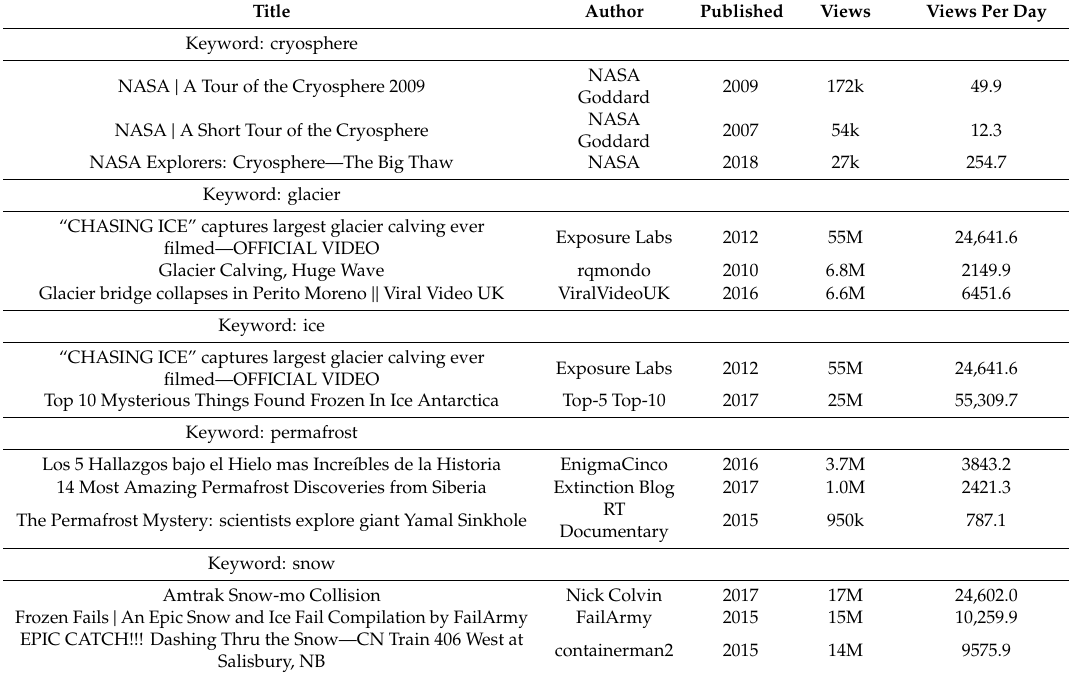
Table 2. The top-viewed videos with cryospheric content. Three top-viewed videos (total views; in February 2019) are shown for each of the five general cryosphere keywords (only two videos with cryospheric content were found among 100 top-viewed videos for the keyword